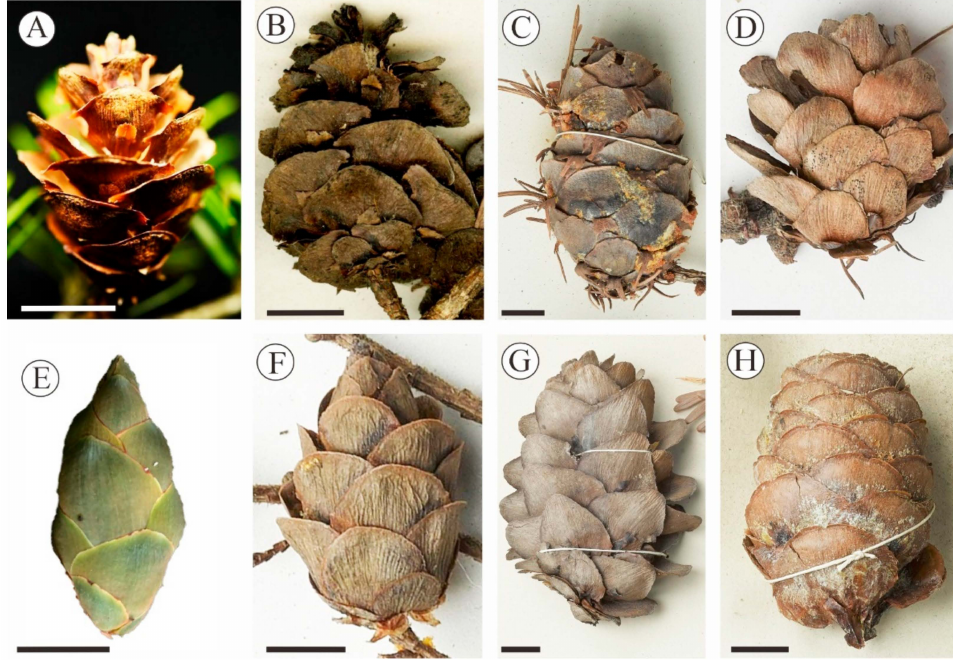
Figure 3. Morphological comparisons for the seed cones from some extant genera within the family Pinaceae. ( A , B ) Nothotsuga longibracteata . ( C ) Pseudotsuga forrestii . ( D ) Larix sibirica . ( E ) Cathaya argyrophylla. ( F ) Tsuga dumosa . ( G ) Keteleeria davidiana . ( H ) Keteleeria fortunei . Scale bars = 10 mm. The seed cones of Larix and Pseudotsuga are similar to present fossil seed cones in